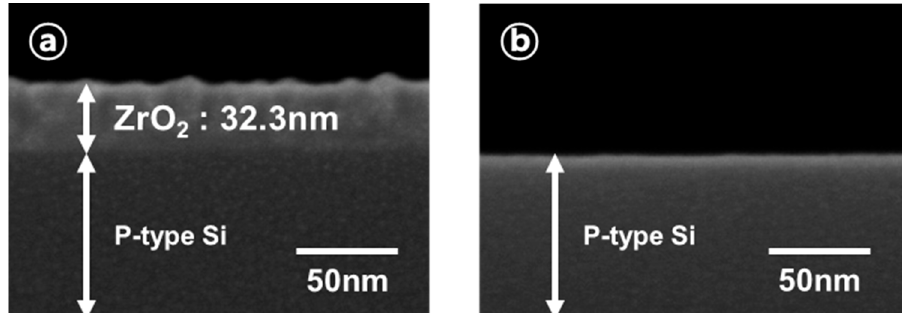
Figure 6. Cross-sectional electron microscopy analysis of ( a ) CMEN-Zr-based ZrO 2 thin films and ( b ) bare Si substrates. Deposition temperature: 150 °C, CMEN-Zr pulse time: 2.5 s, O 2 plasma pulse time: 9 s, PEALD cycle: 350 cycles (~30 nm), substrate: P-type silicon.